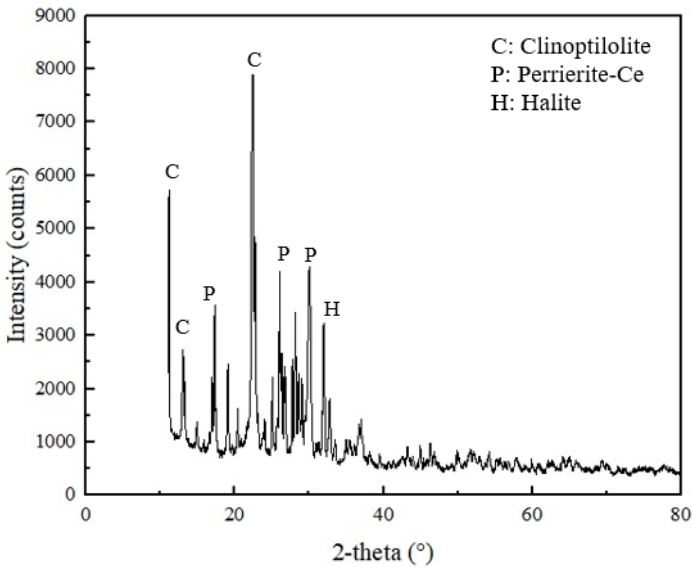
Figure 6. XRD pattern of the solid sample generated with Test 11.